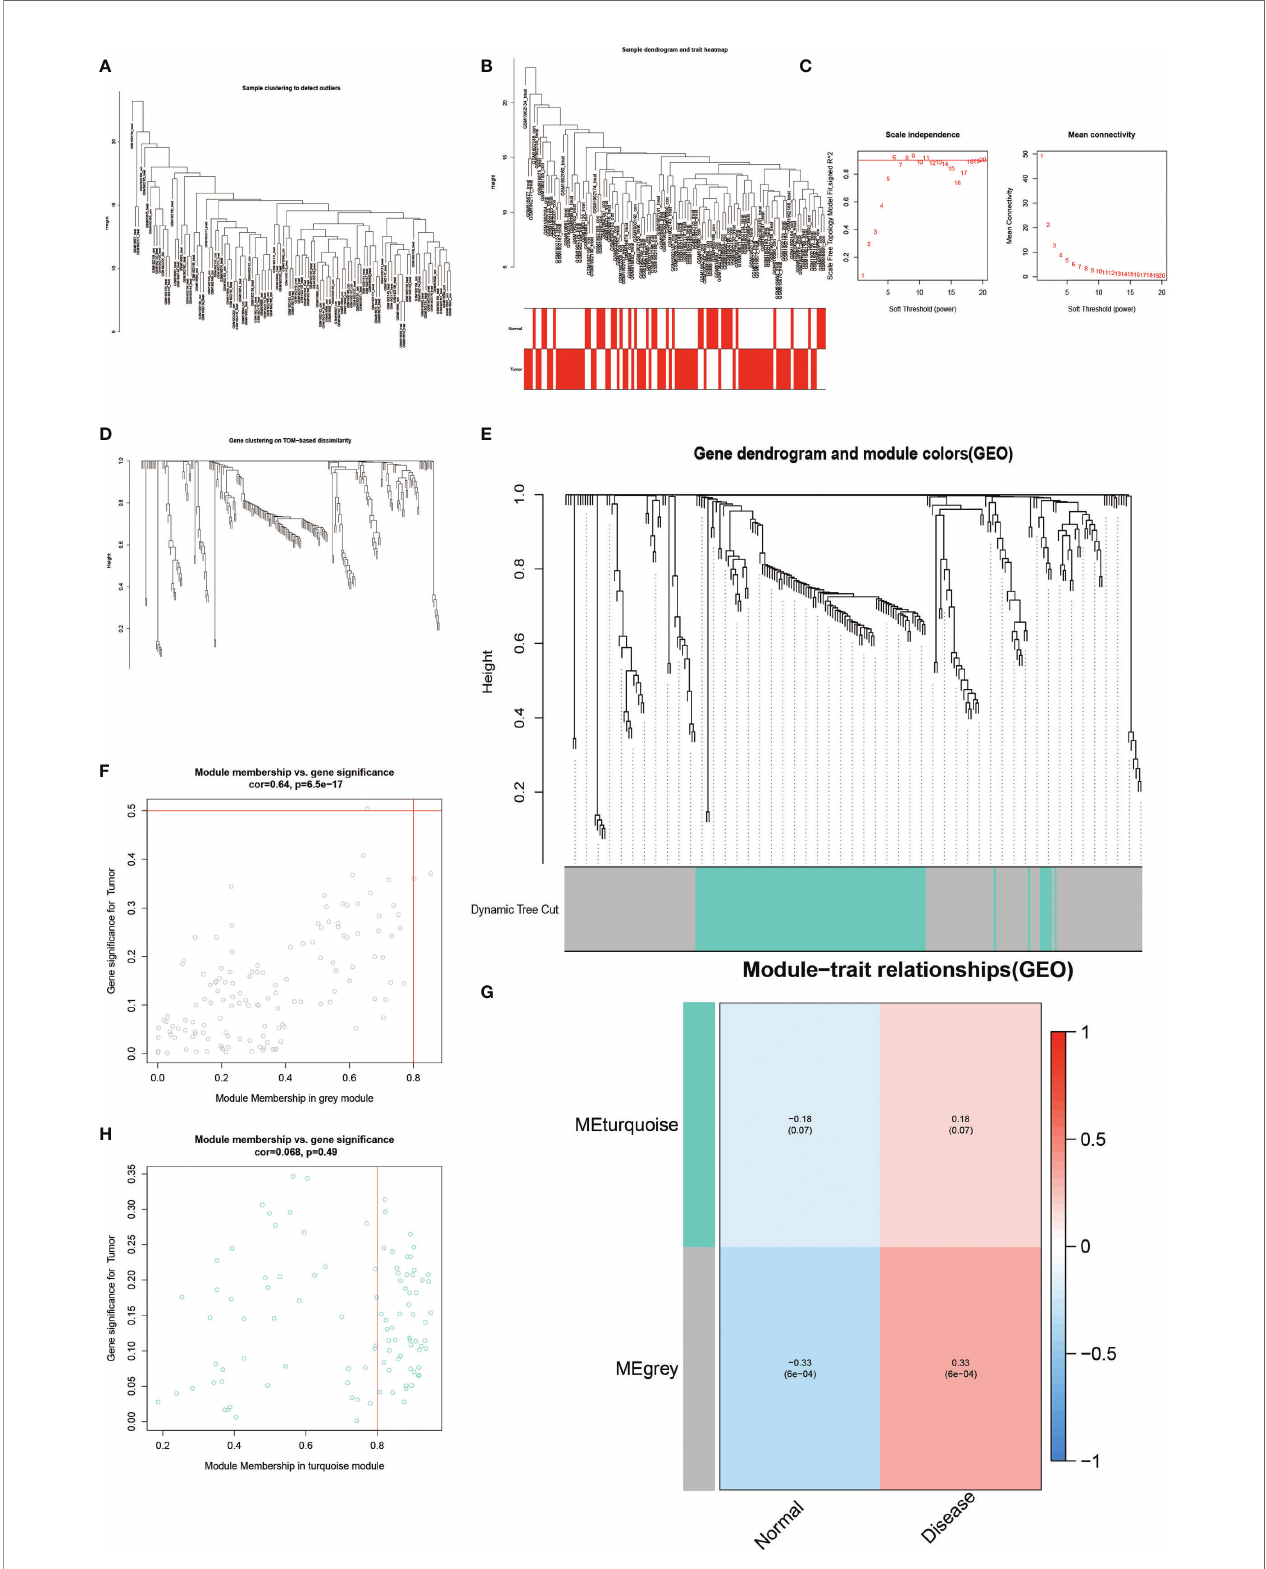
FIGURE 4 | Results of WGCNA analysis. (A-E) shows the results of cluster analysis. (G) shows the Person correlation with disease and normal groups. (F, H) show the scatter plot of